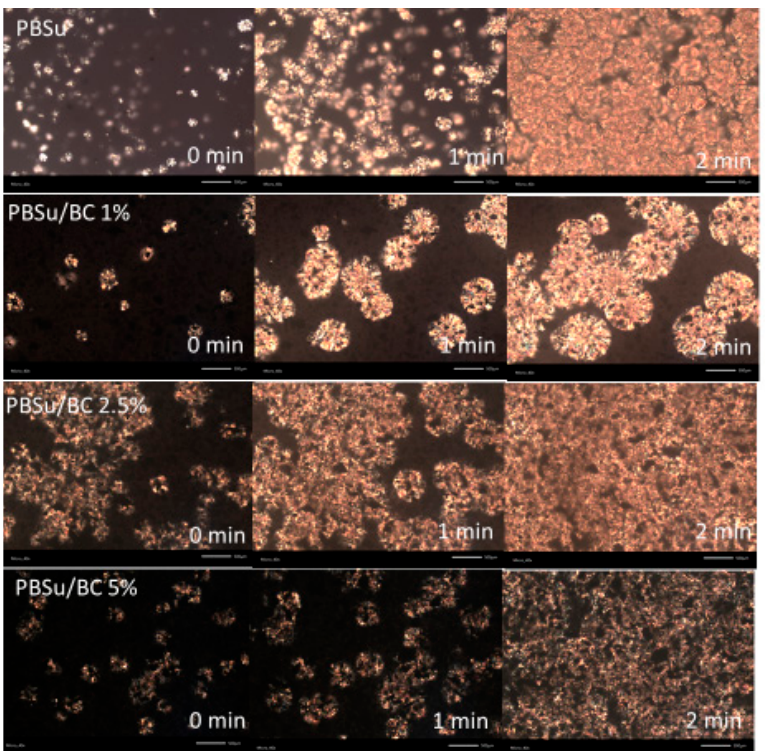
Figure 5. Polarized light microscopy (PLM) images during the time evolution of isothermal crystal- lization of all samples at 90 °C. The added scale bars correspond to 500 μ m and magnification micro- 40.